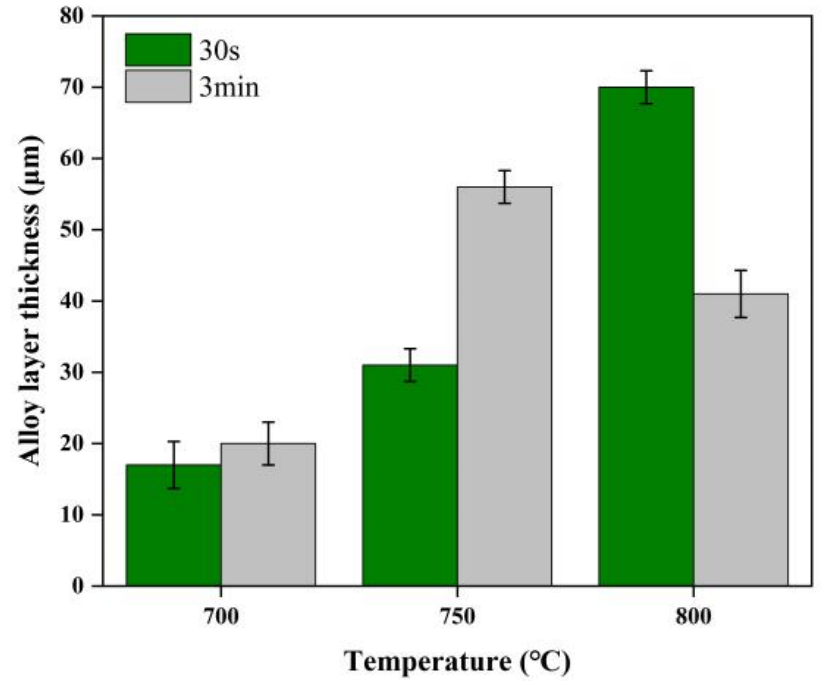
Figure 2. Thickness of intermetallic layer in the coating of Q345 steel after hot dipping at different temperature for 30 s and 3 min.